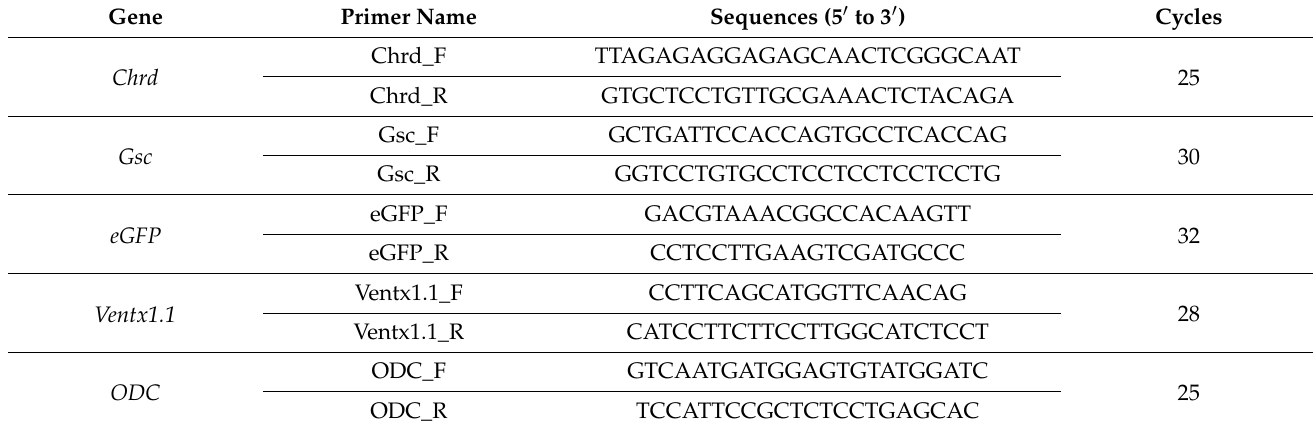
Table 2. Primers used for RT-PCR amplification of several sets of